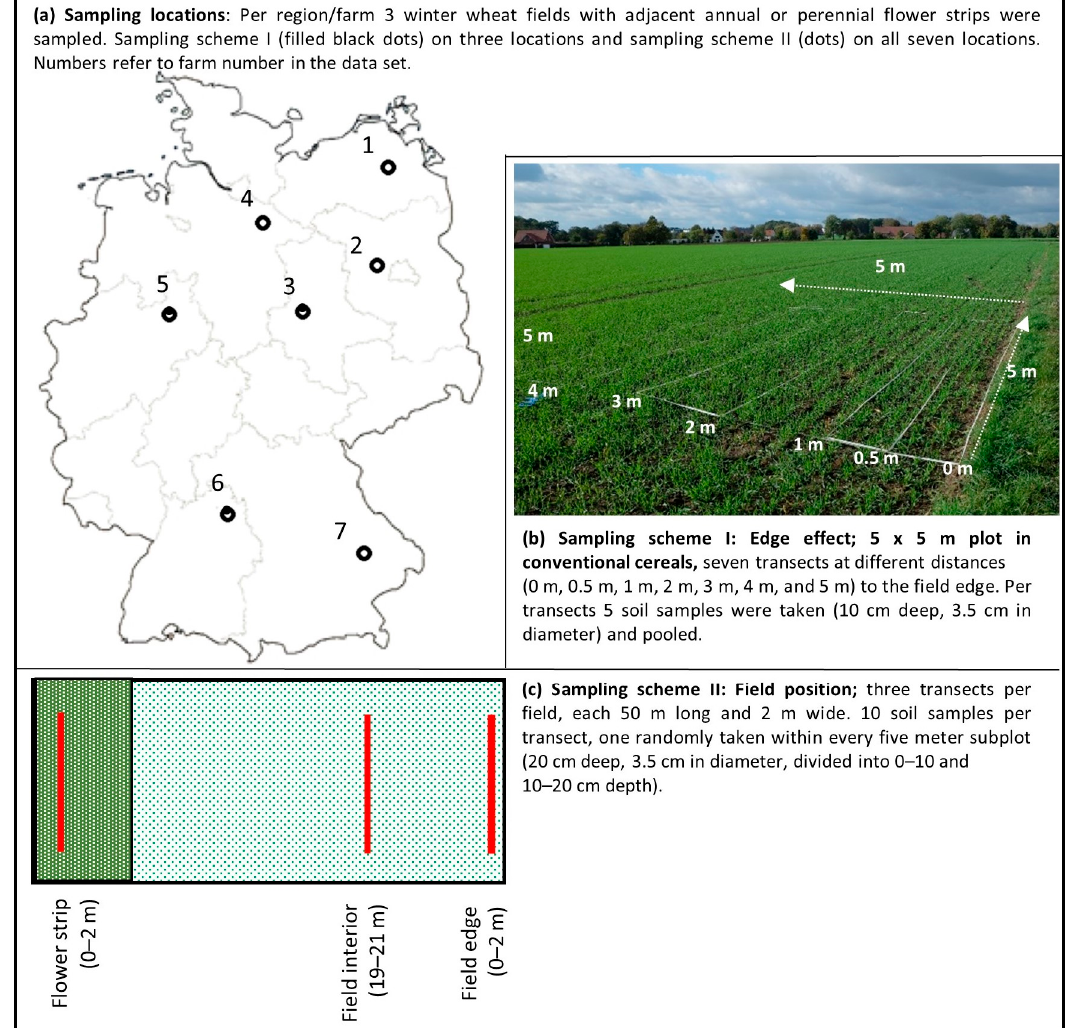
Figure 1. Location of the seven farms in Germany ( a ); sampling scheme I ( b ) and sampling scheme II ( c ) in the fi eld.